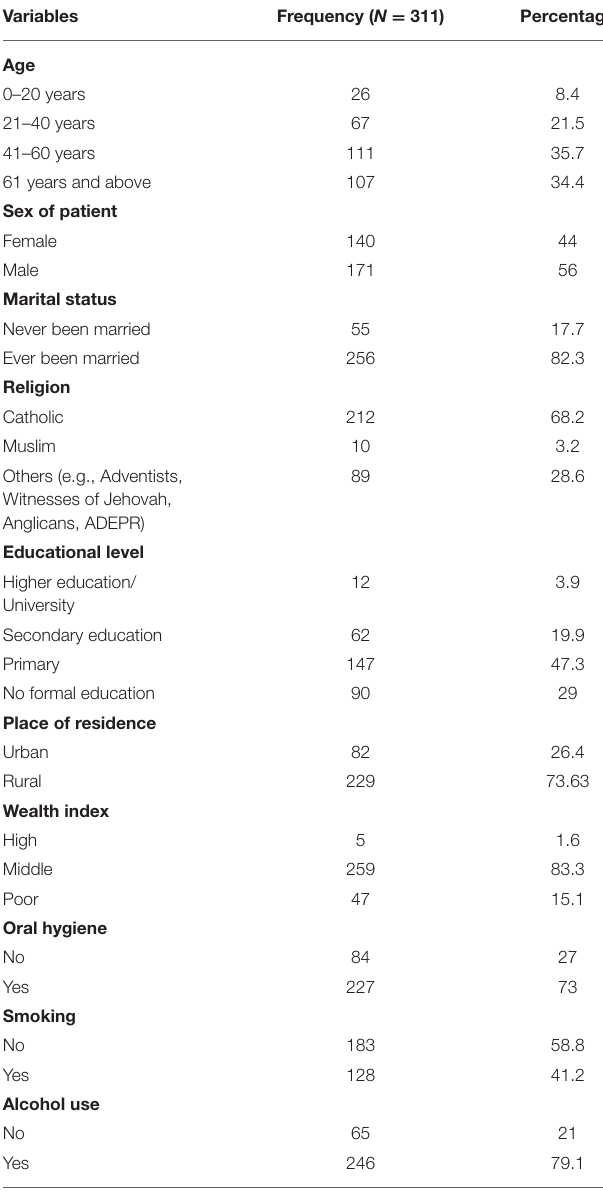
TABLE 1 | Sociodemographic characteristics of